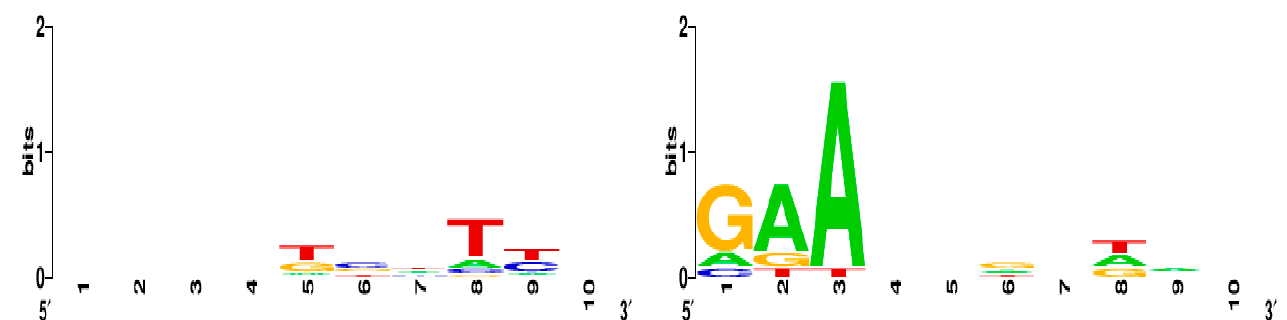
Figure 3. Sequence logo of the 10 bases upstream and the 10 bases downstream of the protospacers. The -GA(A)- sequence in the 10 bases downstream is likely the PAM sequence and is downstream of 17 of the 18 protospacers.